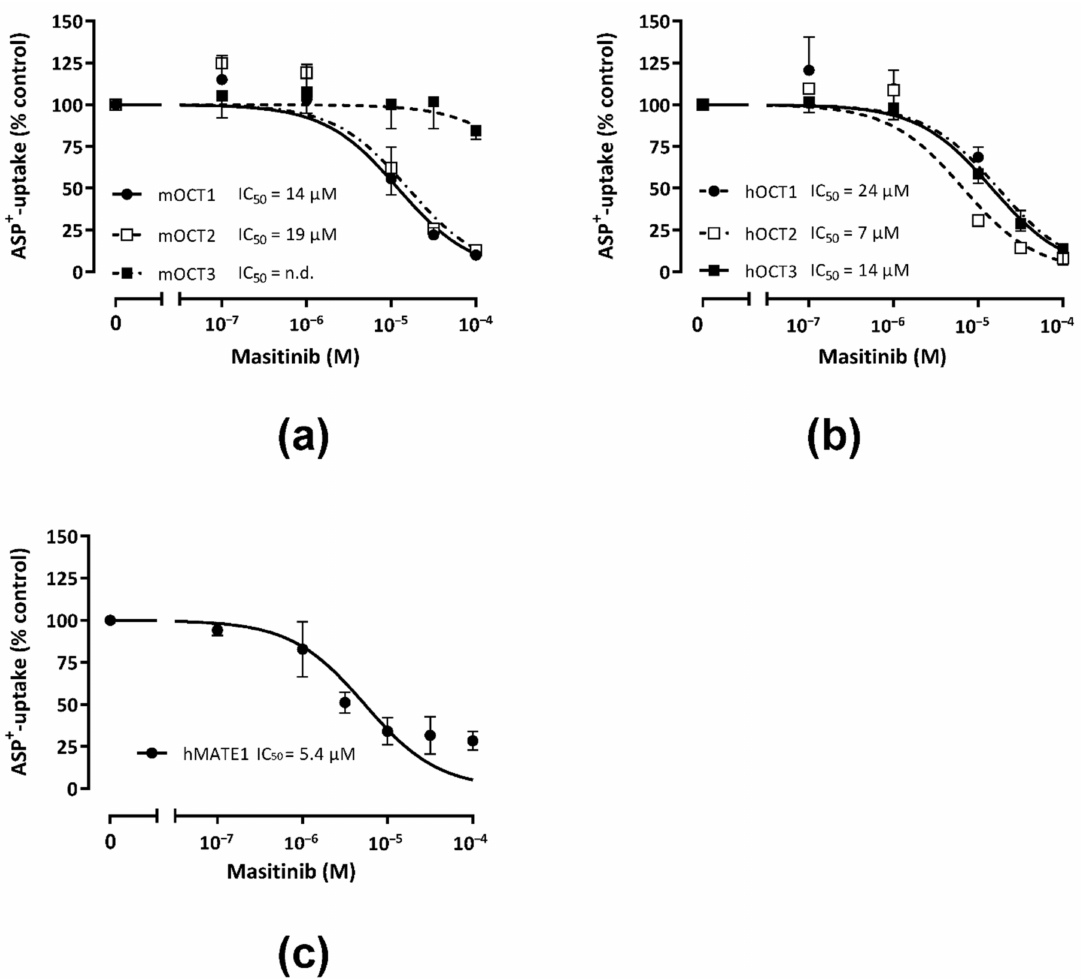
Figure 2. The graphs show the concentration-dependent inhibition of the initial ASP + uptake by Masitinib in HEK293 cells stably expressing murine (panel ( a )), or human (panel ( b )) OCTs and human MATE1 (panel ( c )). The y -axis displays the ASP + -uptake in % of control experiments without Masitinib (=100%). Values are mean ± SEM calculated in 18–50 replicates measured in at least 3 independent experiments. The IC 50 -values for each OCT are indicated in the inserts. Panel a shows the inhibition of ASP + (1 µ M) uptake by increasing Masitinib concentrations in HEK293 cells stably transfected with mOCT1- (closed dots), mOCT2- (open squares), or mOCT3 (closed squares). For mOCT3, the IC 50 -value could not be determined (n.d.), while Masitinib inhibited the ASP + uptake by mOCT1 and mOCT2 with a similar apparent affinity (14 and 19 µ M, respectively). Panel b shows the inhibition of ASP + (1 µ M) uptake by increasing Masitinib concentrations in HEK293 cells stably transfected with hOCT1- (closed dots), hOCT2- (open squares), or hOCT3 (closed squares). Masitinib inhibited the ASP + uptake by hOCT1, hOCT2, and hOCT3 with a similar apparent affinity (24, 7, and 14 µ M, respectively). Panel c shows the inhibition of ASP + (1 µ M) uptake by increasing Masitinib concentrations in HEK293 cells stably transfected with hMATE1- (closed dots). Masitinib inhibited the ASP + uptake by hMATE1 with a high apparent affinity (5 µ